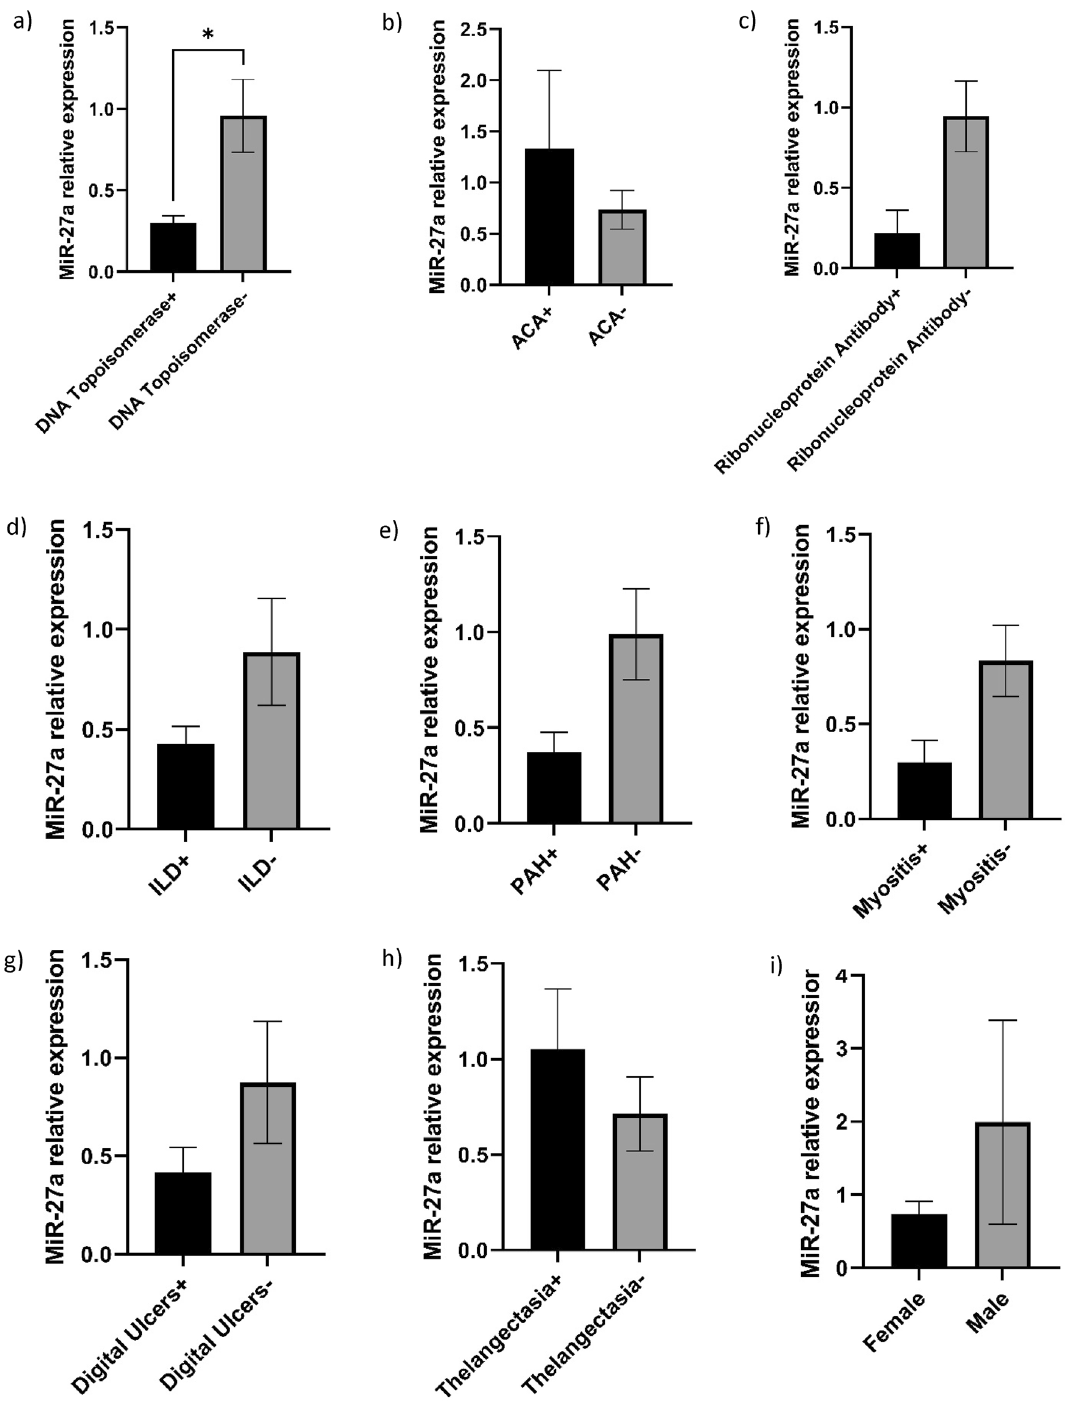
Figure 3. Comparing the expression of miR-27a between different binary situations. ( a ) comparison of miR- 27a expression patients positive or negative for DNA topoisomerase (SCL70), ( b ) Comparison of miR-27a expression patients positive or negative for anti-centromere antibody, ( c ) comparison of miR-27a expression patients positive or negative for ribonucleoprotein autoantibody, ( d ) comparison of miR-27a expression patients positive or negative for interstitial lung disease, ( e ) comparison of miR-27a expression patients positive or negative for pulmonary arterial hypertension, ( f ) comparison of miR-27a expression patients positive or negative for myositis, ( g ) comparison of miR-27a expression patients positive or negative for digital ulcers, ( h ) comparison of miR-27a expression patients positive or negative for telangiectasia, and, comparison of miR-27a expression between female and the few male